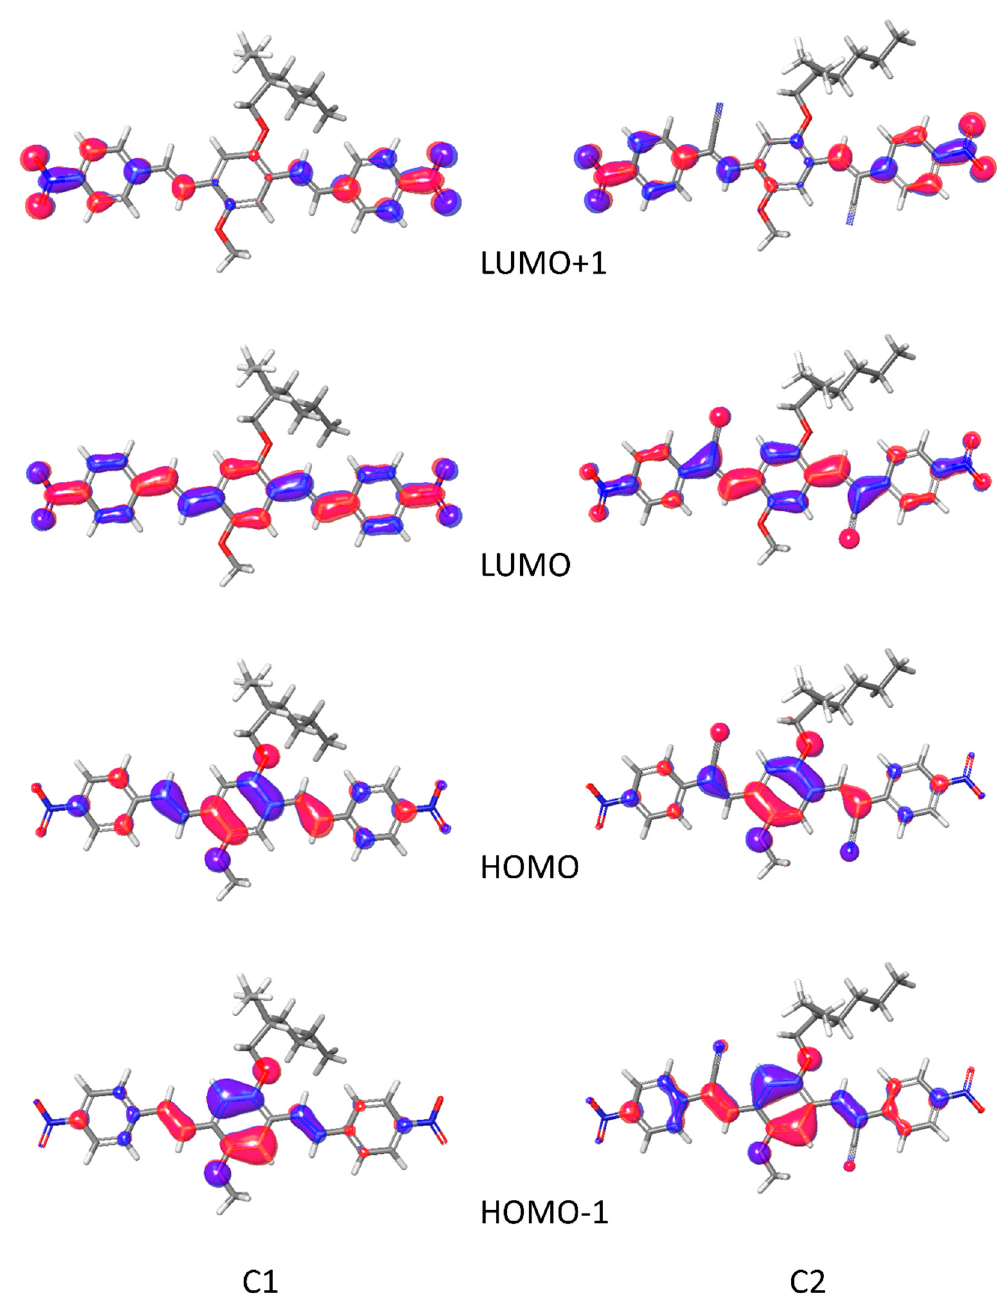
Figure 10. HOMO-1, HOMO, LUMO, and LUMO+1 orbitals for C1 ( left ) and C2 ( right ).